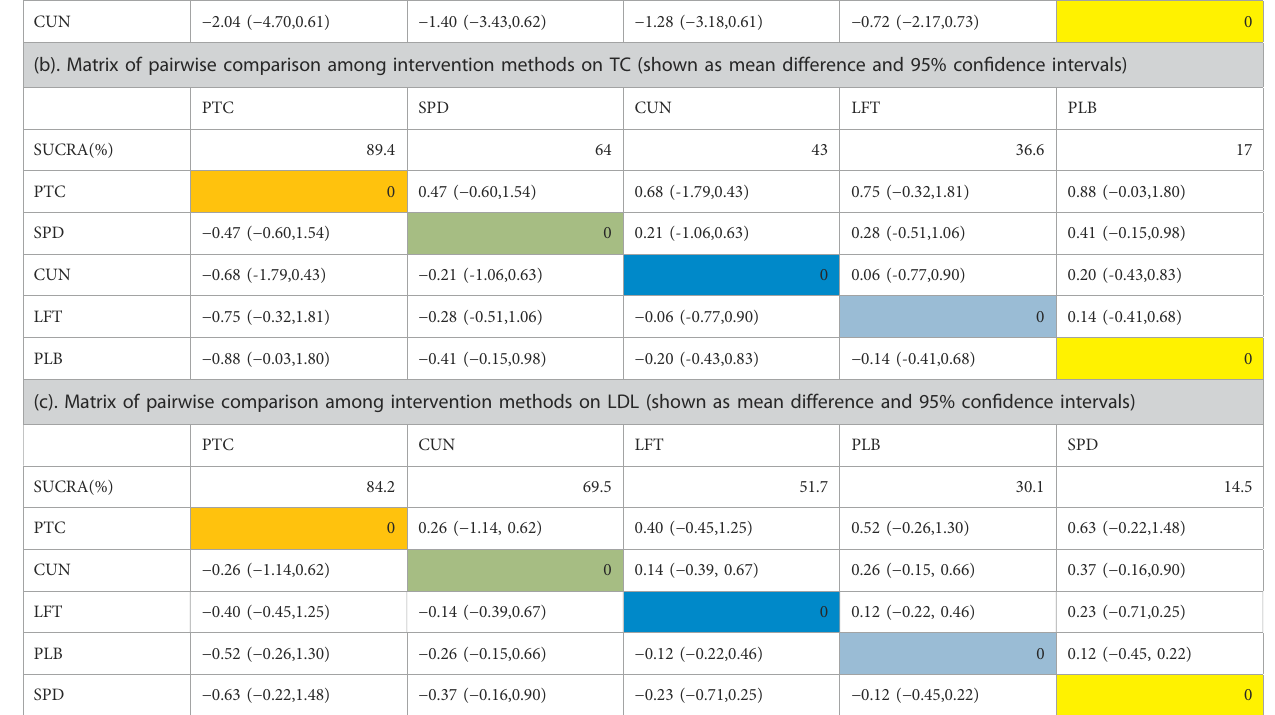
(c). Matrix of pairwise comparison among intervention methods on LDL (shown as mean difference and 95% con fi dence